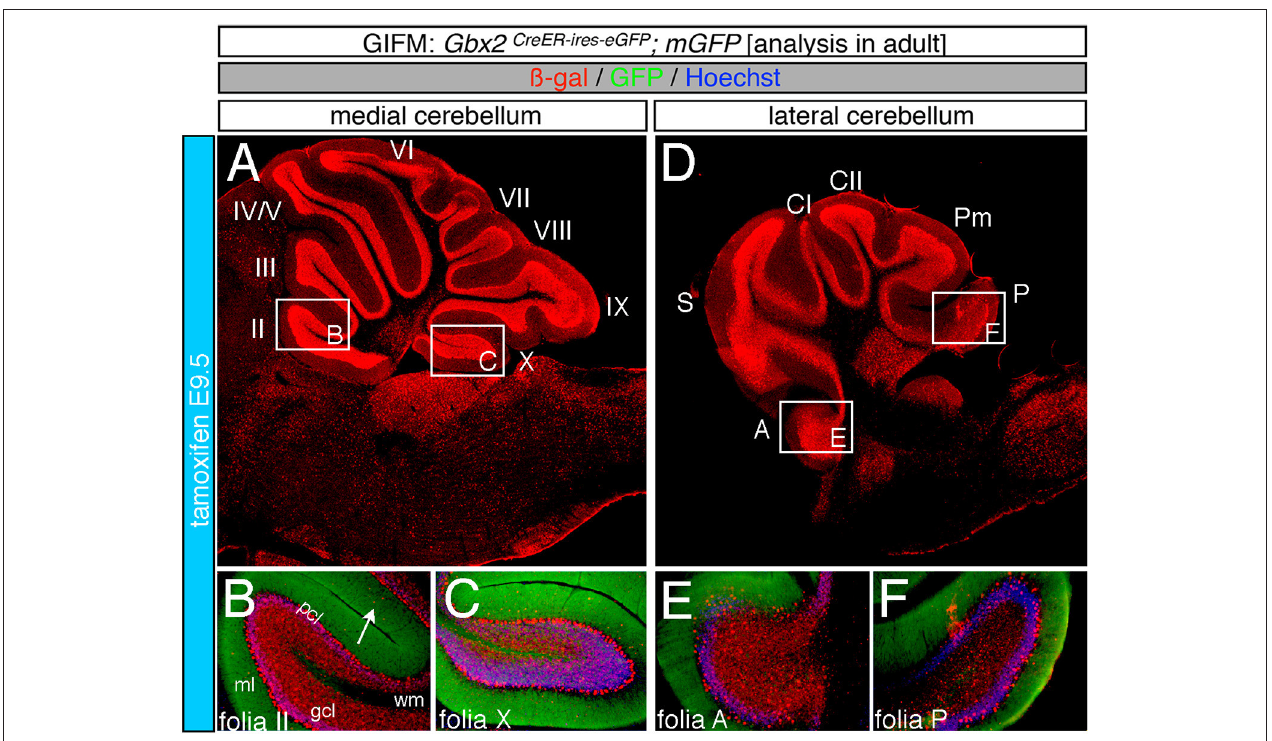
FIGURE 4 | Progenitors expressing Gbx2 at E9.5 delineates the peak contribution to granule cells in the adult Cb. ICC on adult sections with antibodies that label ß-gal (red) and GFP (green). (A–F) Gbx2 expressing progenitors marked at E9.5 produced fewer granule cells than marking at earlier time points. These Gbx2-derived granule cells were predominantly localized to the anterior Cb, with a substantial bias toward the anterior hemispheres (E) . This intermediate marking stage also generated the peak Gbx2 lineage contribution to Purkinje cells. Gbx2 -derived Purkinje cells populated every folia, but the greatest contribution was observed in the posterior vermis. White arrow demarcates Gbx2 -derived nuclei in the molecular layer. Scale bar: 180 µ m (A,D) , 90 µ m (B,C,E,F) . See Supplemental Figure 2 for fate mapping summary of Gbx2 lineage contribution to granule cells when marked at an intermediate